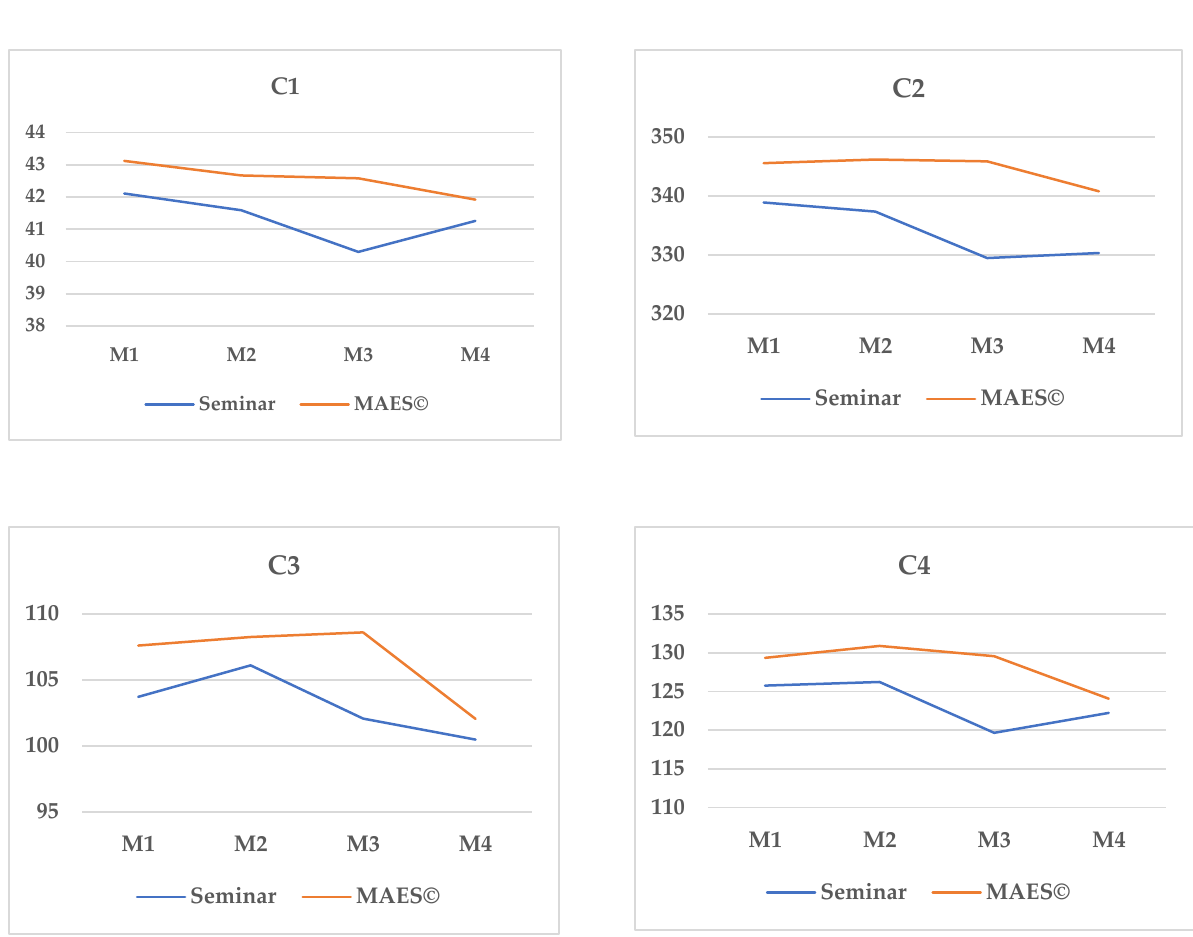
Figure 2. Pair-wise comparison of the measurements of the groups who took part in training through traditional practical clinical seminars on clinical skills and learning with MAES©. M = Measure; C1 = exerts according to the legislation, ethics, and the professional orientation within the area of perioperative nursing; C2 = provides perioperative nursing care integrating knowledge and evidence-based practice in a safe environment; C3 = establishes and maintains effective interpersonal relationships with the users and the surgical team during the perioperative process; C4 = promotes a culture of surgical patient safety; M1: first measurement (post-intervention, right after the intervention); M2: second measurement (3 months); M3: third measurement (6 months); M4: fourth measurement (9 months).